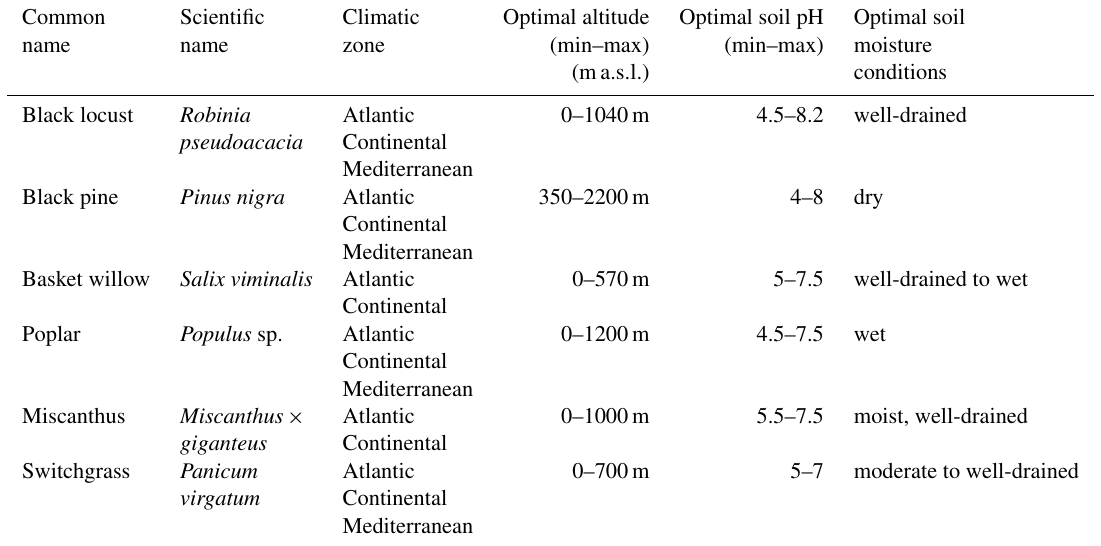
Table 3. Selected bioenergy crops screening criteria – specific growing conditions.